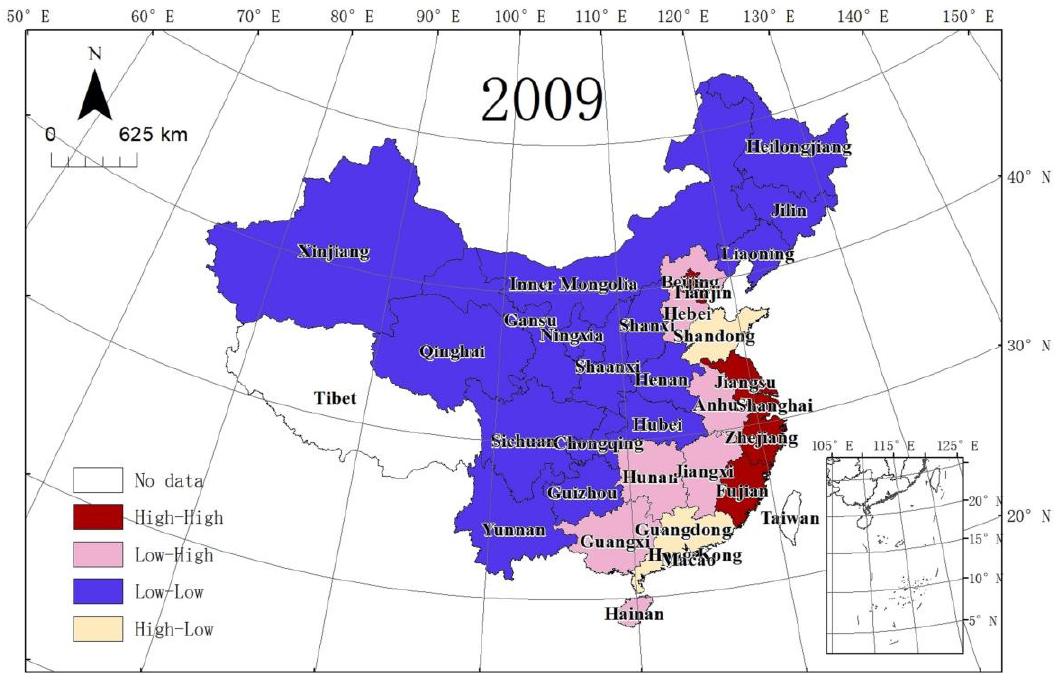
Figure 3. The Moran scatterplot maps of WRGUE in 30 provincial administrative units in 2009.